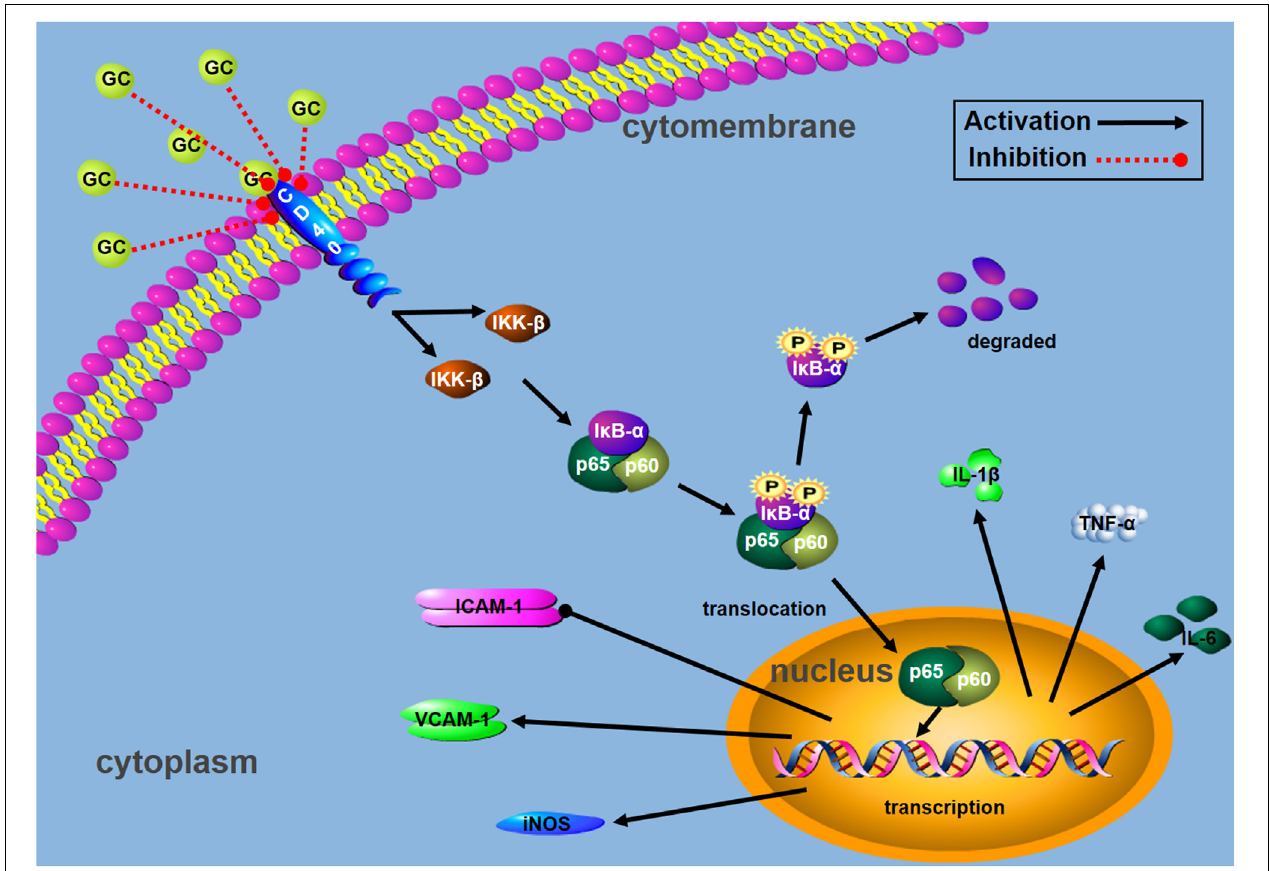
FIGURE 9 | Schematic diagram describing the mechanism in the inhibitory effect of GC on H/R-induced ventricular myocytes inflammatory injury: activation;